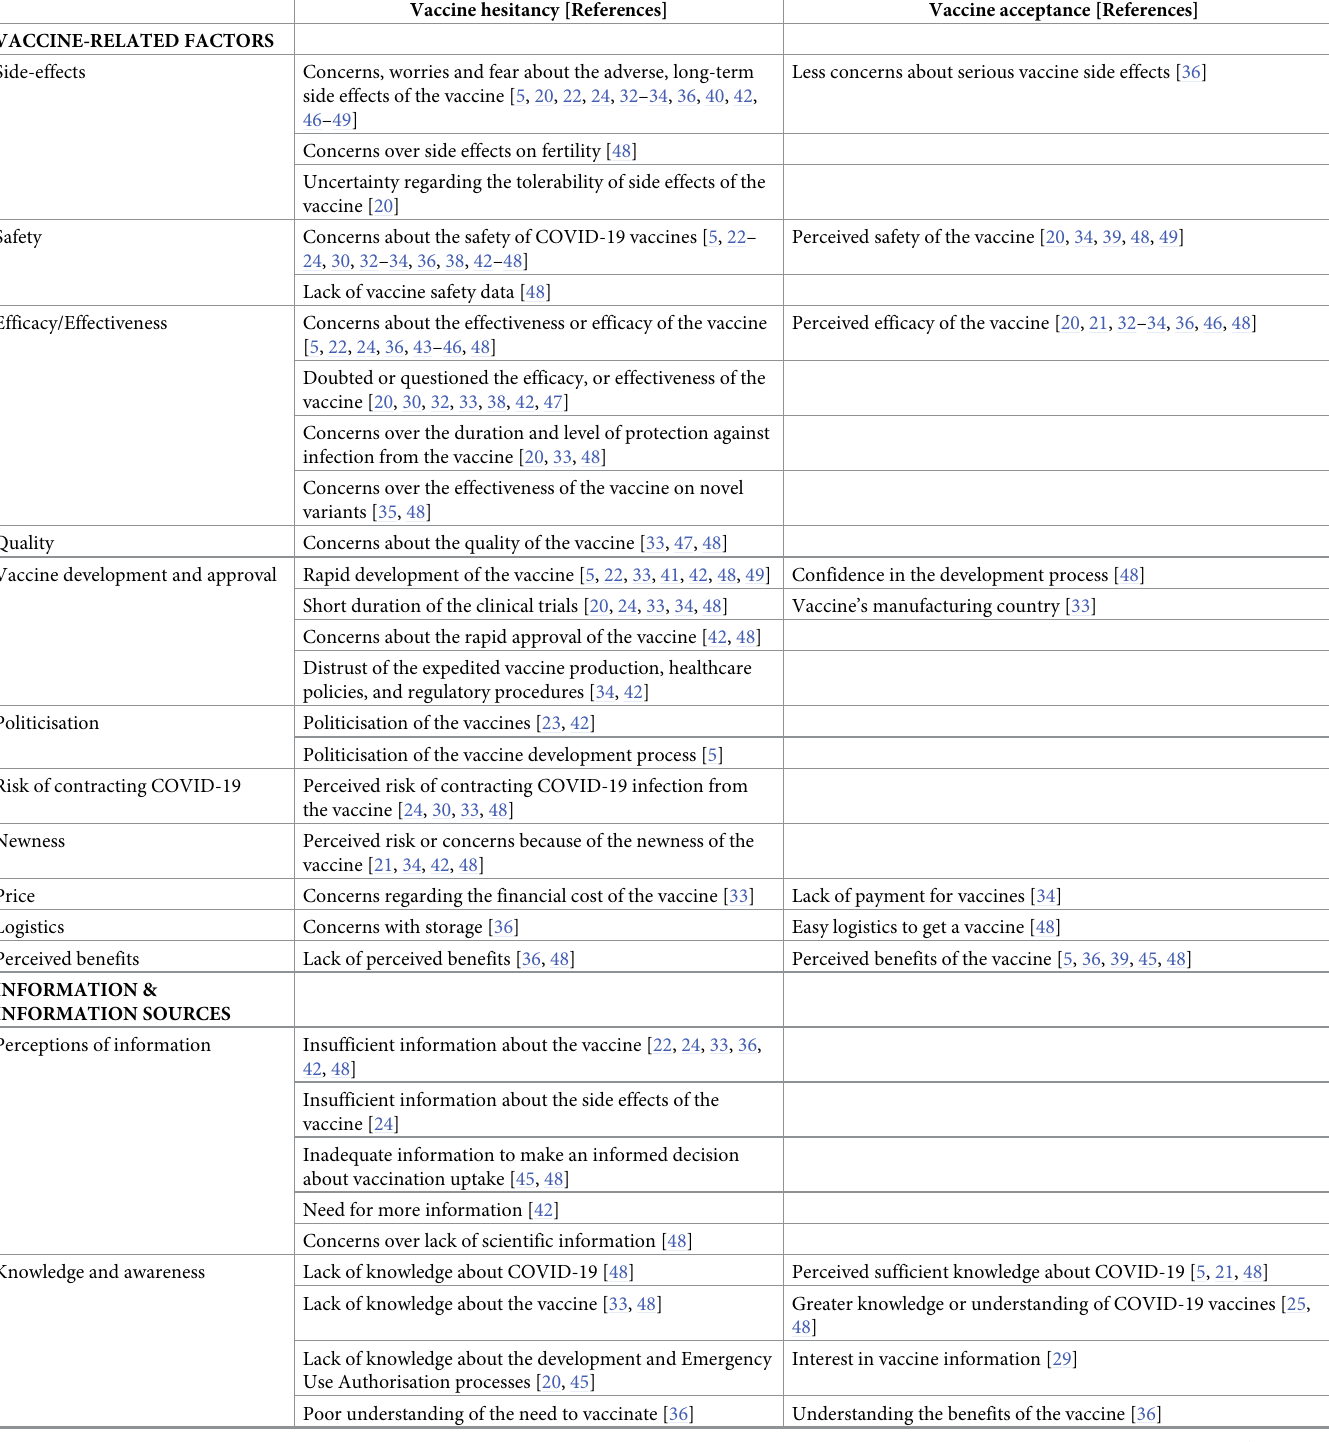
Table 5. Factors associated with vaccine hesitancy and vaccine acceptance for